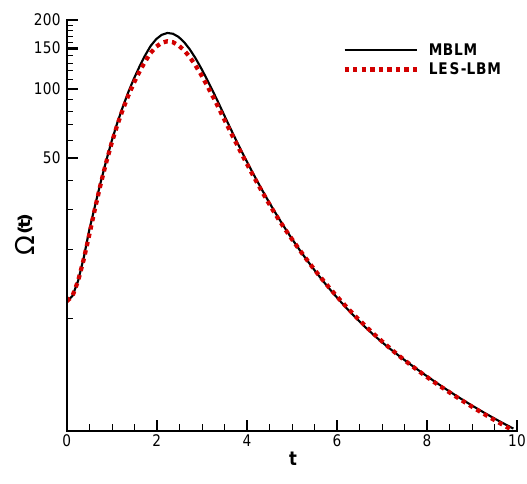
Fig. 8 Comparison of enstrophy evolution at Re λ = 314 on mesh 256 3 .